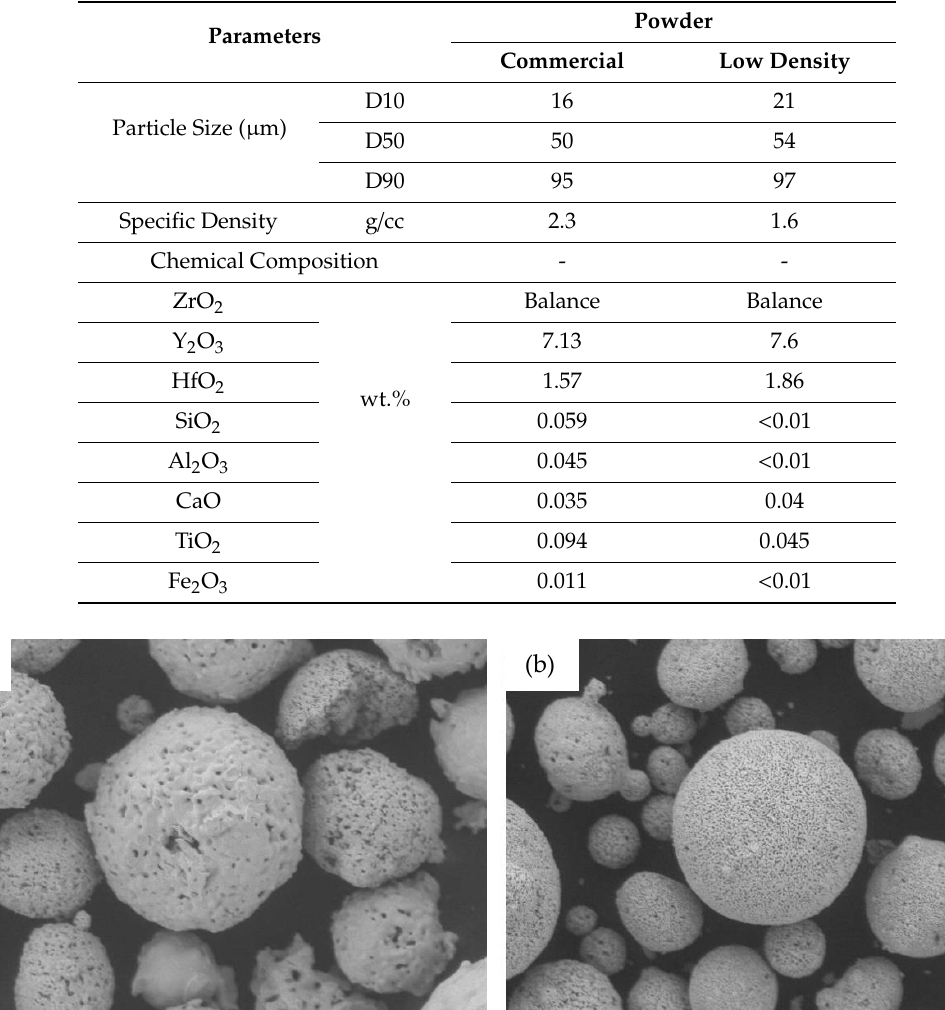
Table 1. Summary of powder physical and chemical properties for commercial and experimental Low-Density powders.